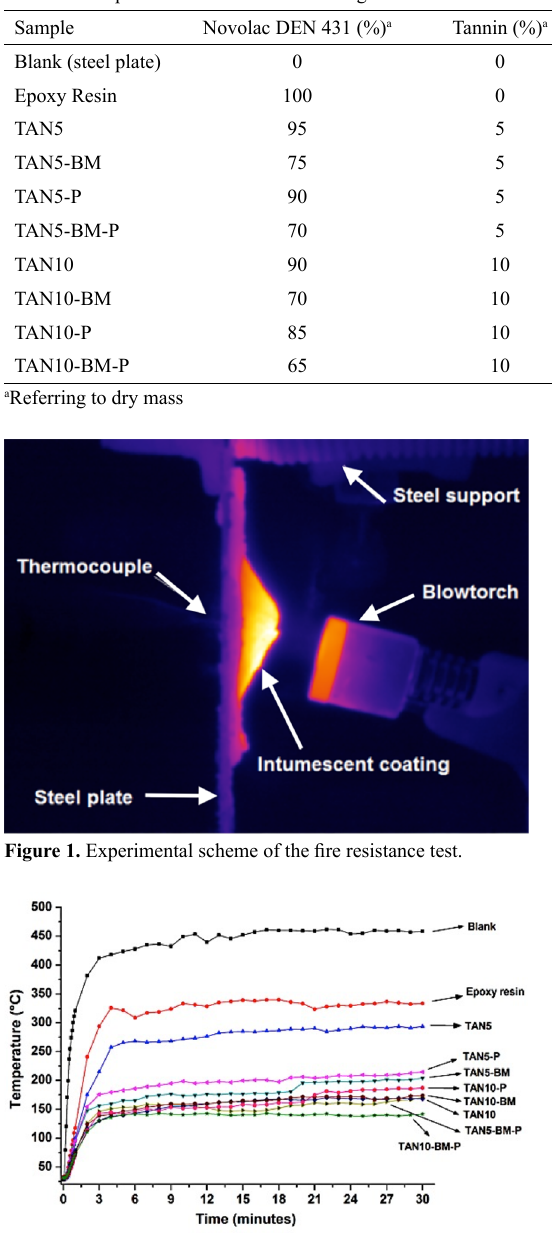
Figure 2. Temperature monitoring over time for different paint